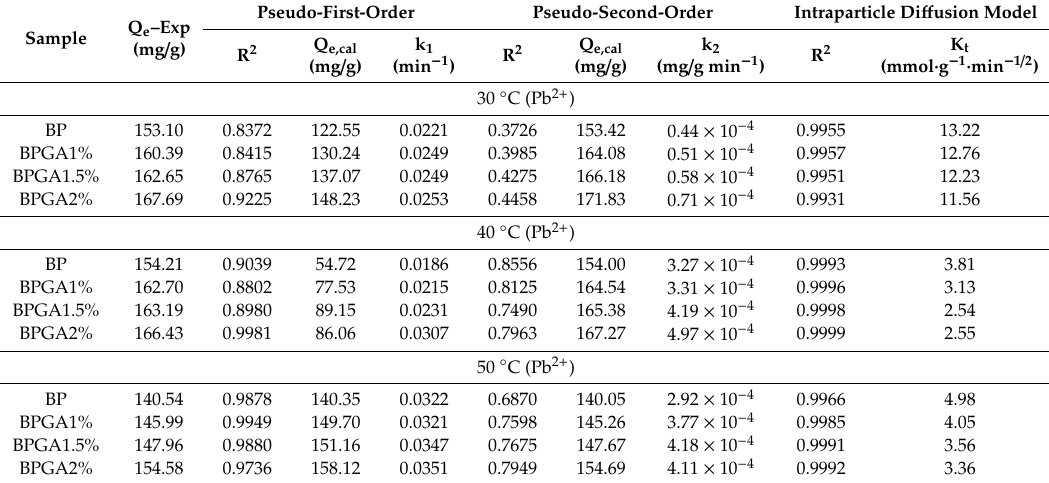
Table 2. Adsorption kinetics parameters for the adsorption of Pb 2 + ions onto the adsorbents.